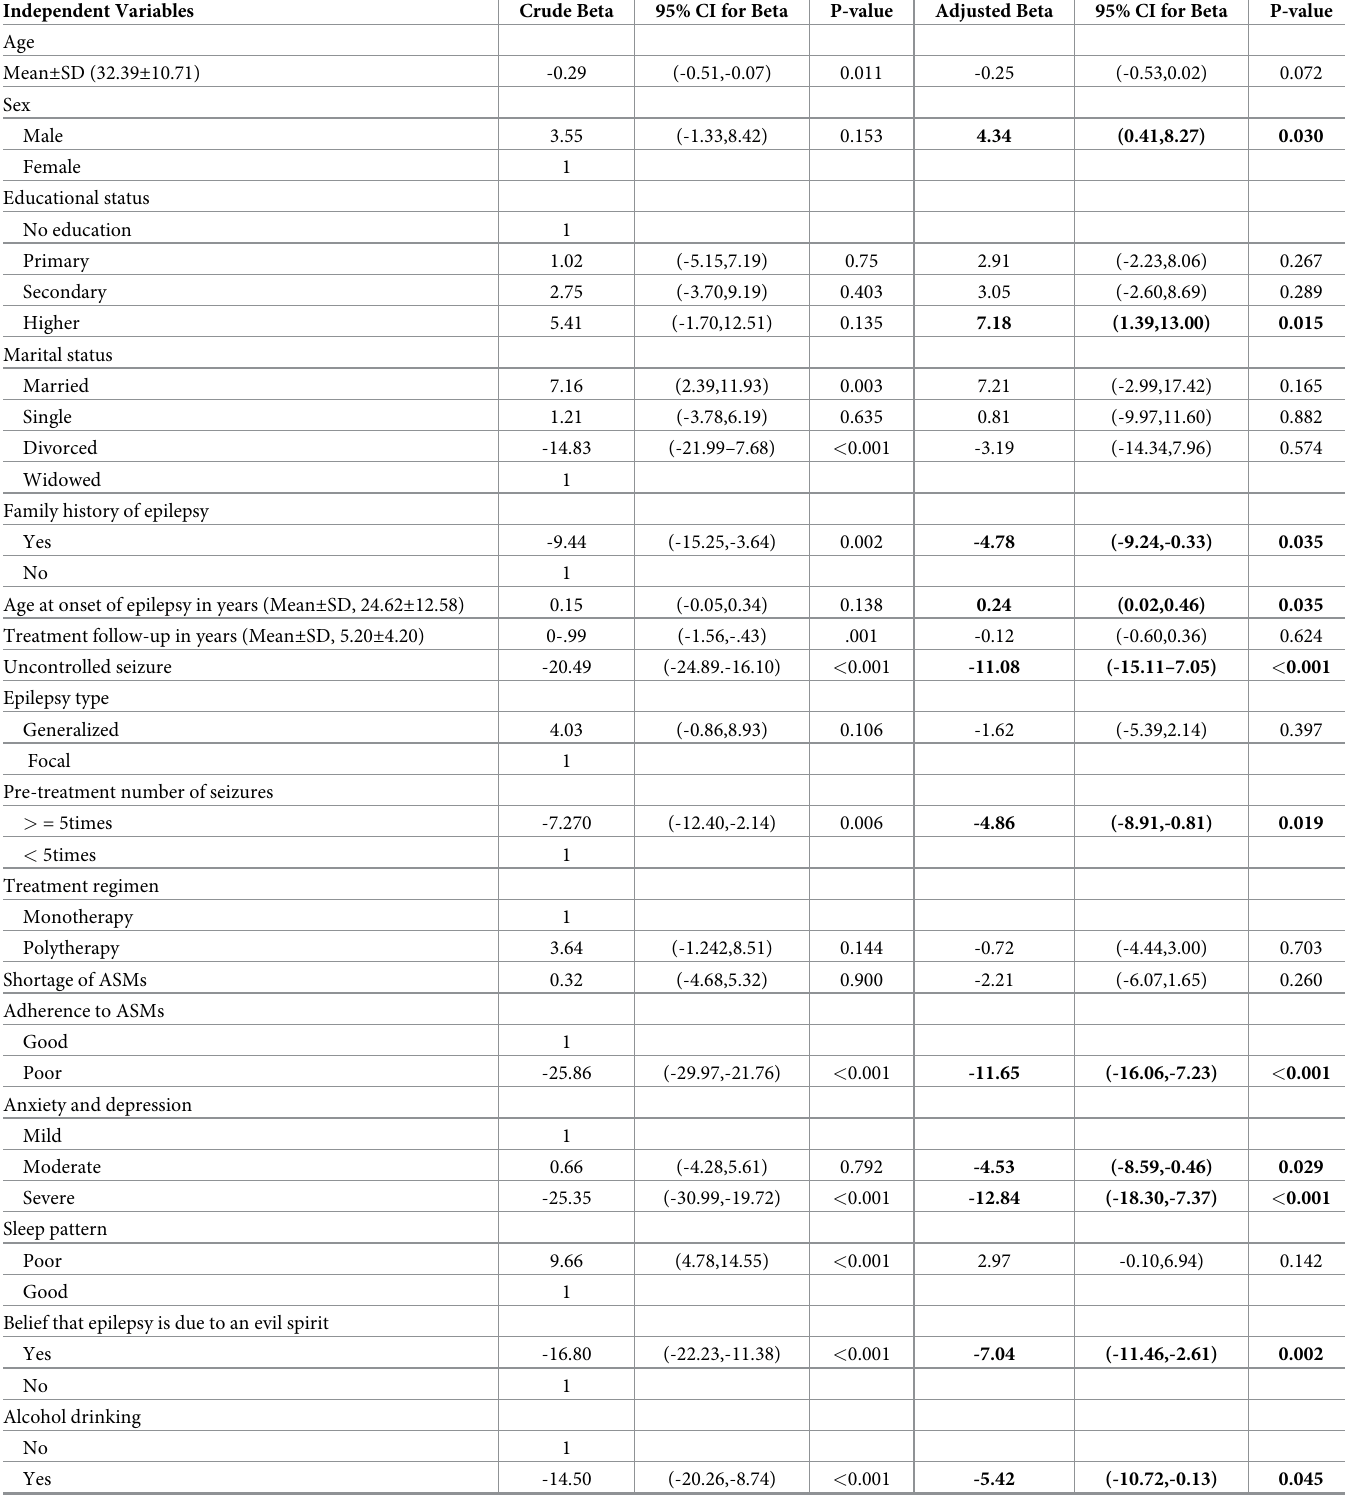
Table 3. Linear regression analysis of factors for health-related quality of life in epileptic patients ( n =